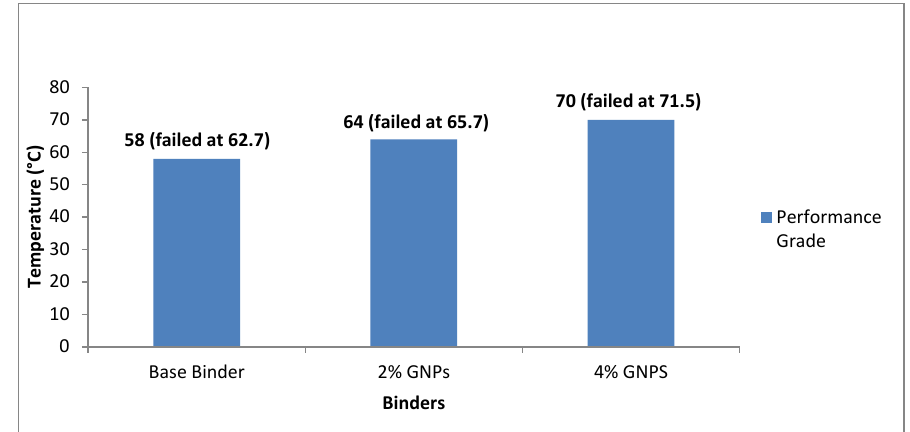
Figure 2. The performance grades (PGs) of the asphalt binders.